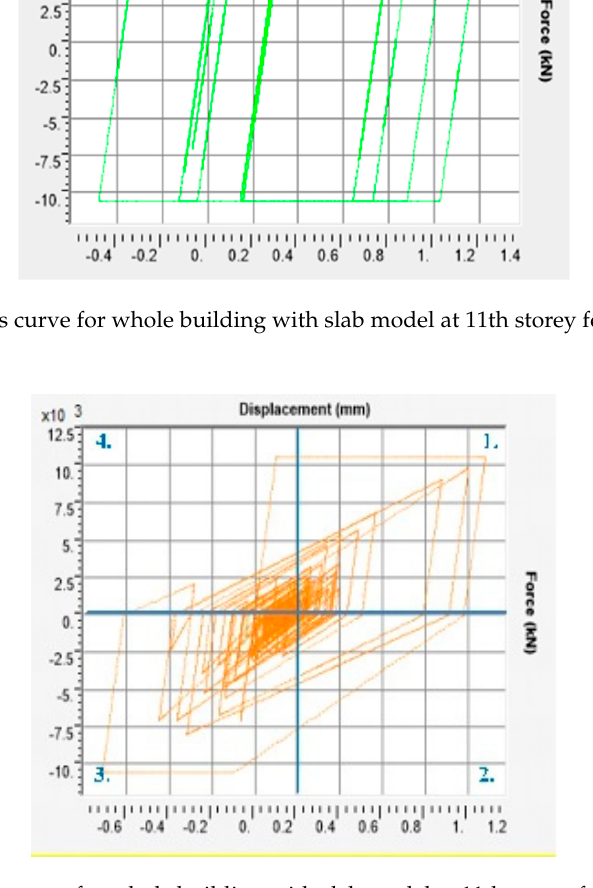
Figure 11. Hysteresis curve for whole building with slab model at 11th storey for the THC model in the ULS